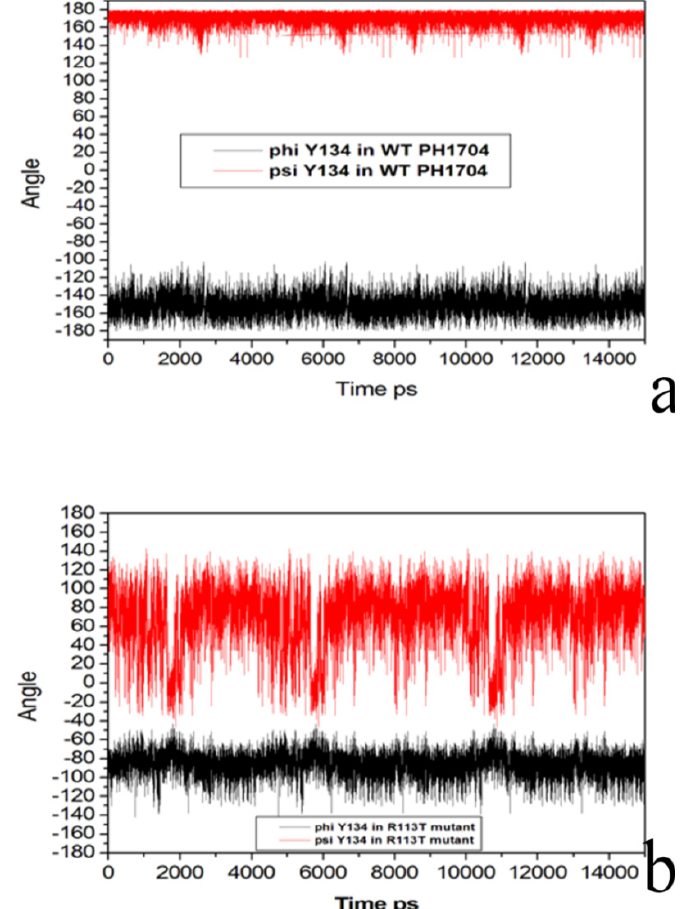
Figure 9. ( a ) Phi and psi dihedral angles of Tyr134 in R113T mutant; ( b ) Phi and psi dihedral angles of Tyr134 of Cl − bind state during